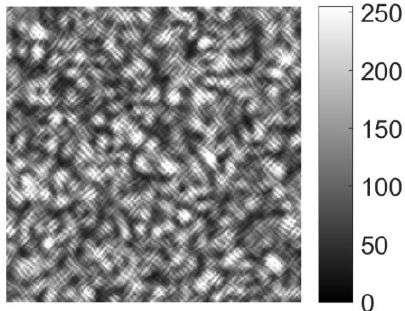
Figure 6. Enlarged view of the speckle pattern obtained using DSPI.